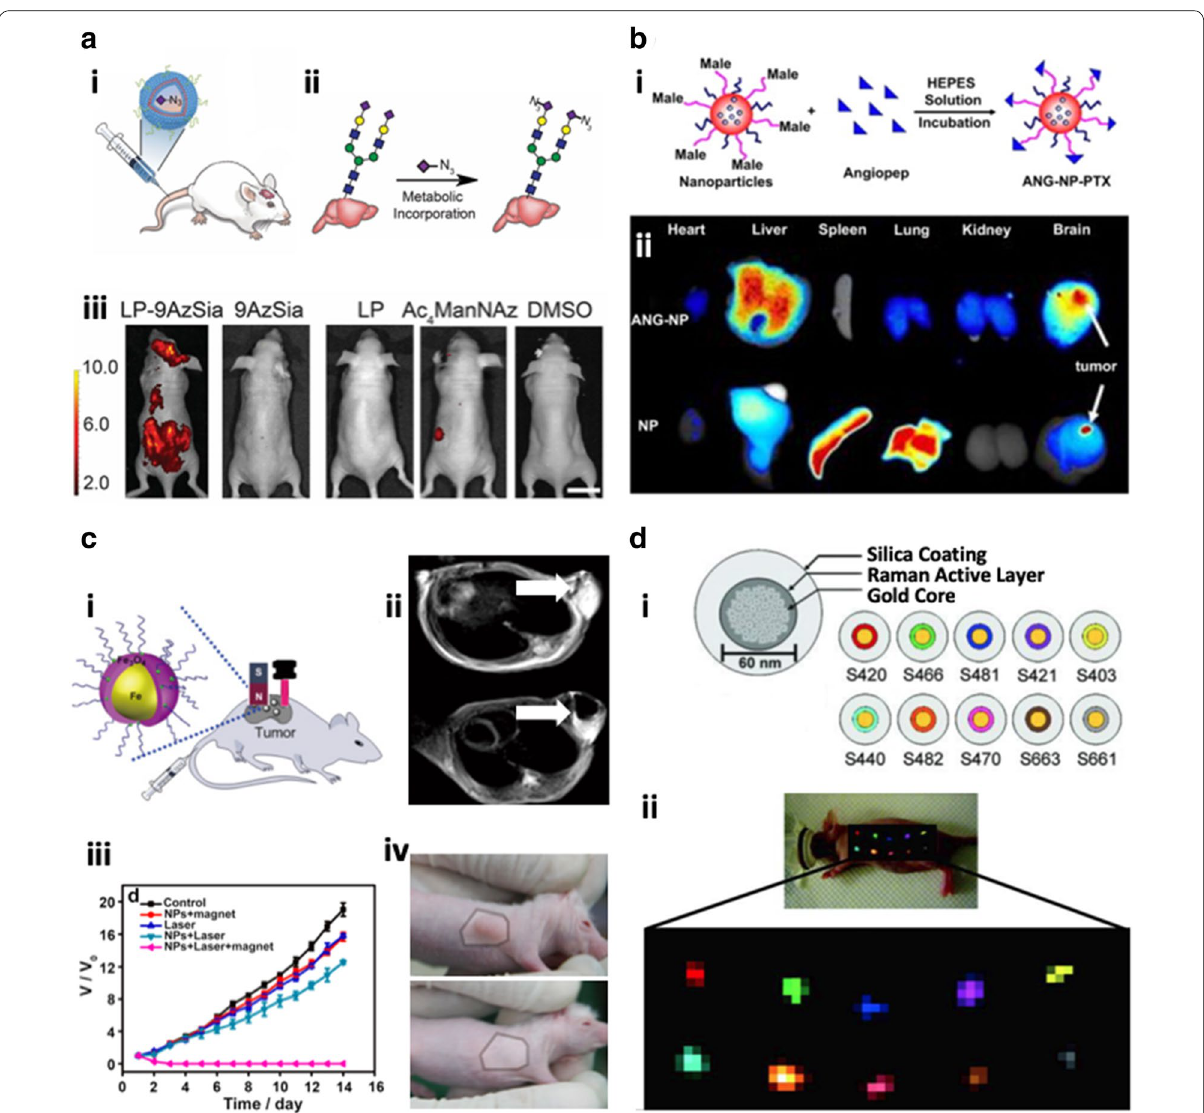
Fig. 1 Class of nanomedicines applied in medical fields. a Nanoliposome used for the delivery of therapeutic drugs or imaging agents. i Schematic illustration of PEGylated liposomes bearing 9AzSia that can be injected i.v. through the tail vein. ii Schematic description of 9AzSia incorporation mechanism into the brain tissue through the binding to sialic acid. iii The liposomes bearing 9AzSia were significantly accumulated in the